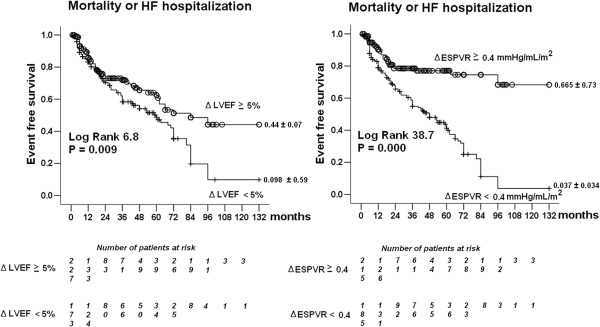
Prognostic predictors – Left panel. Kaplan-Meier survival curves (considering combined death or HF hospitalization as an endpoint) in medically treated patients stratified according to the presence of stress ΔLVEF ≥ 5% vs rest as cut-off value. Right panel. Kaplan-Meier survival curves (considering combined death or HF hospitalization as an endpoint) in medically treated patients stratified according to the presence of stress ΔESPVR ≥ 0.4 mmHg/mL/m2 vs rest as cut-off value.